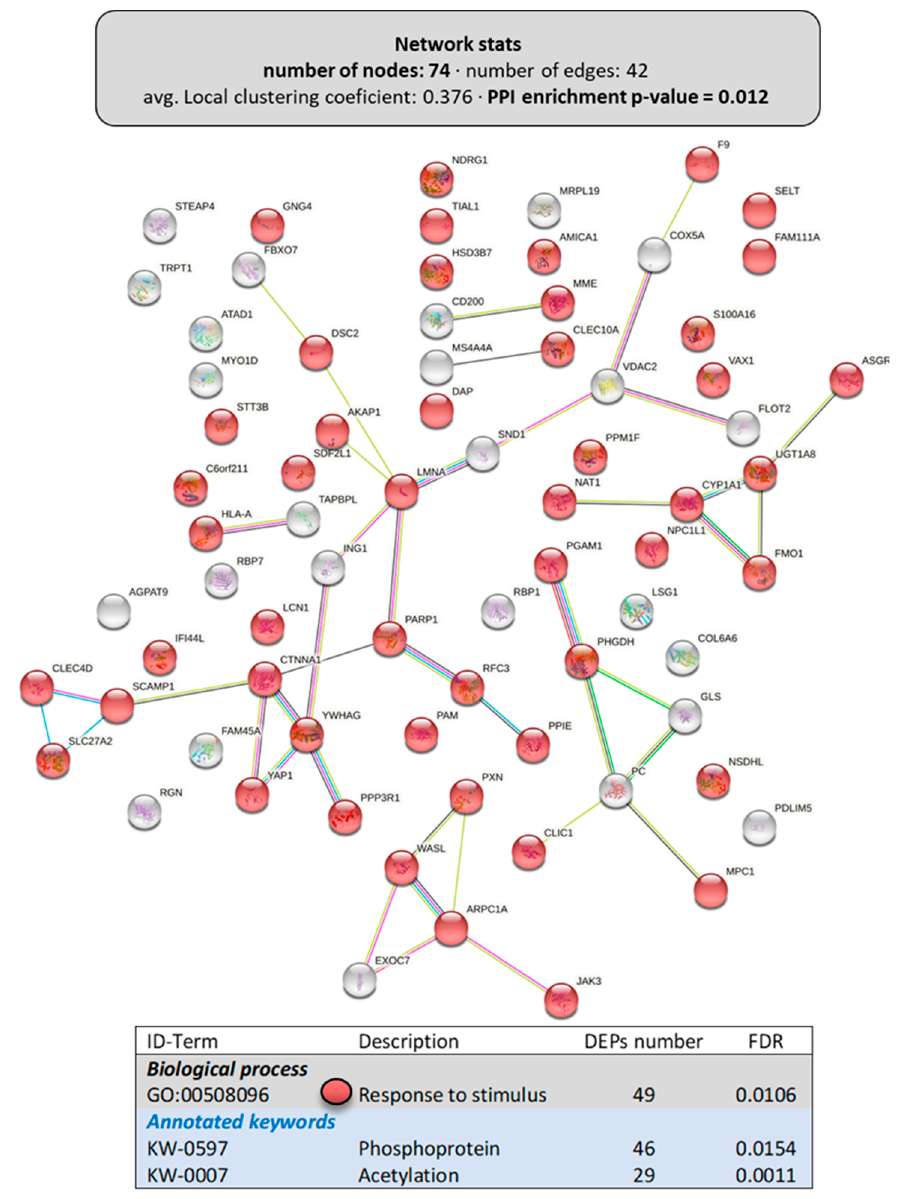
Figure 8. Specific network of the downregulated DEPs in the liver of LPL-fed salmon. Each node represents one differentially expressed protein (DEP) obtained from liver shotgun proteomics. Details on the functional network statistics (network stats) are indicated ( top ). The selected relevant biological processes are presented with the corresponding colors in each node, together with the annotated keywords related to post-translational modifications ( bottom table ).